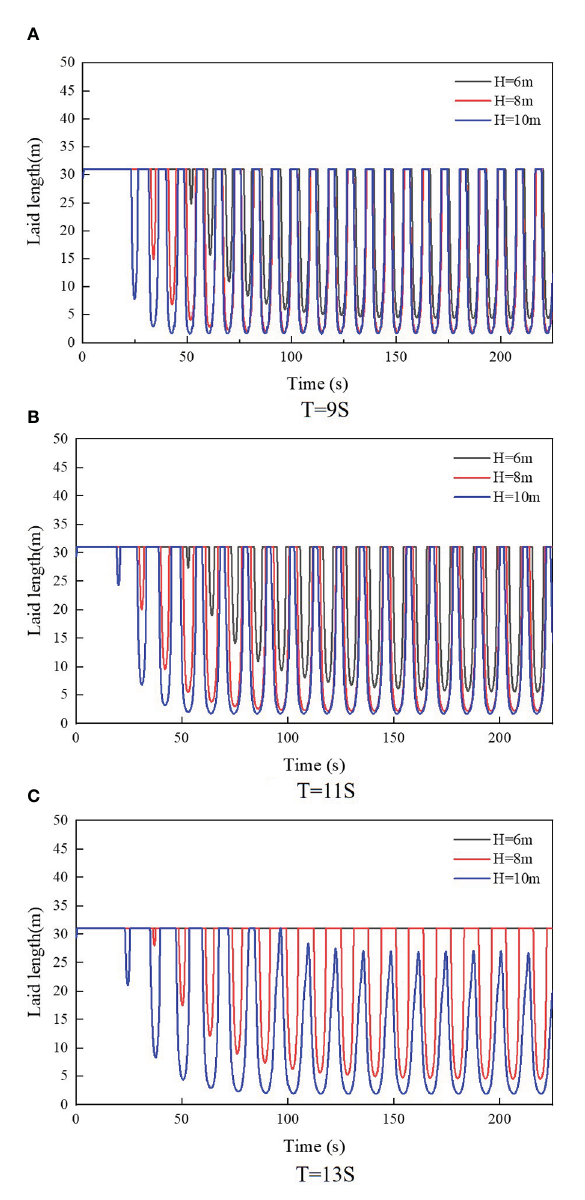
FIGURE 12 Time-domain curves of laid length of fi sh farm platform under different wave